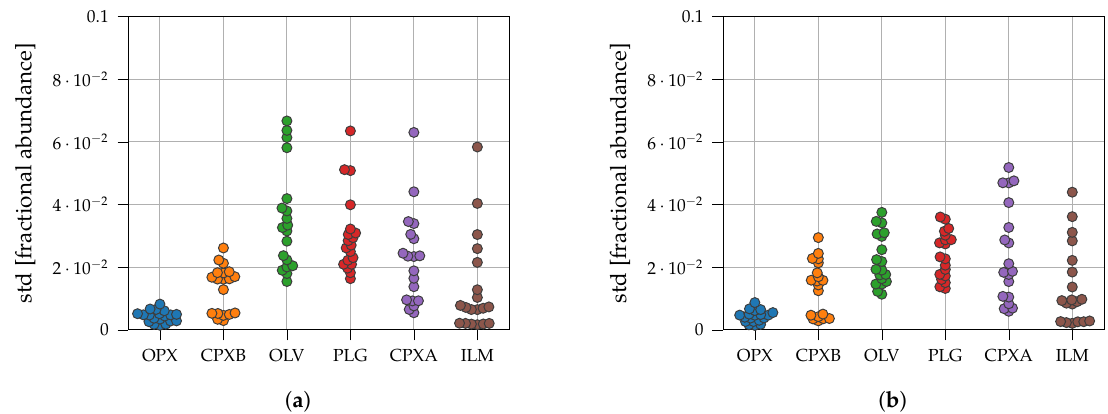
Figure 21. Uncertainties associated with each of the mineral abundances for the unmixing of the LSCC spectra. ( a ) TiO 2 and Al 2 O 3 prior; ( b ) All